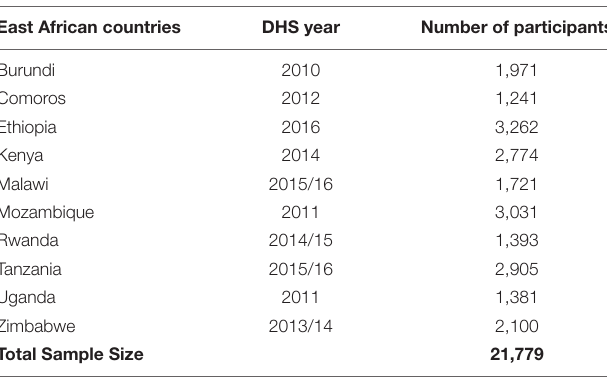
TABLE 1 | The demographic and health survey (DHS) years of study and study participants of undernutrition in the 10 East African countries from 2010 to 2016. East African countries DHS year Number of participants